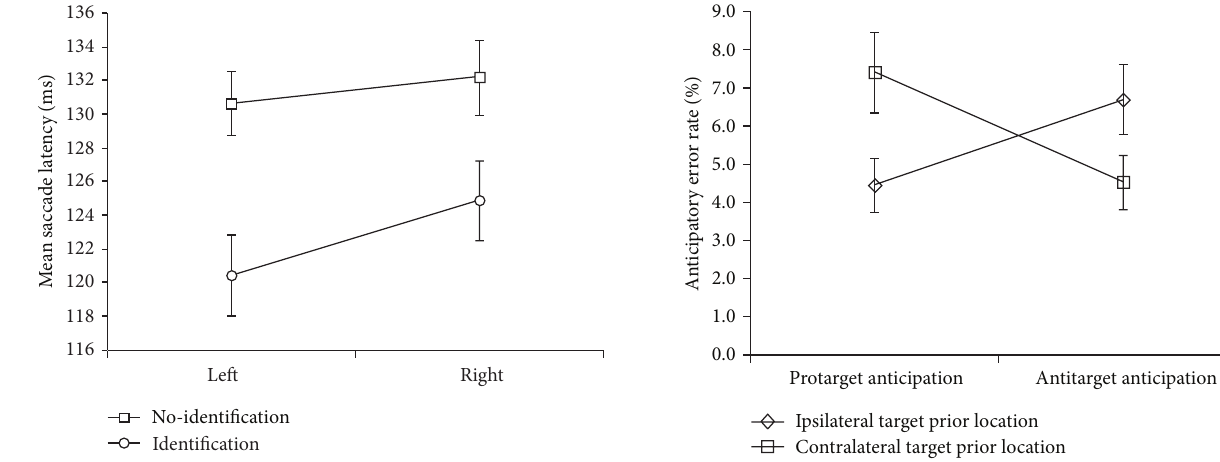
Figure 7: Mean percent of anticipatory eye movements under ISR conditions. Anticipatory eye movement two-way interaction for target prior location × anticipatory type. Note: Protarget = anticipation in same direction as target. Antitarget = anticipation in opposite direction from target. Ipsilateral = same direction target prior location. Contralateral = opposite direction target prior location. Error bars = ± 1